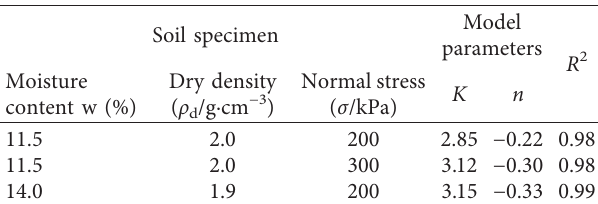
w � 11.5%, ρ � 2.0g/cm 3 , σ � 200kPa. (b) w � 11.5%, h ). (a) d Table 2: Model parameters of different soil